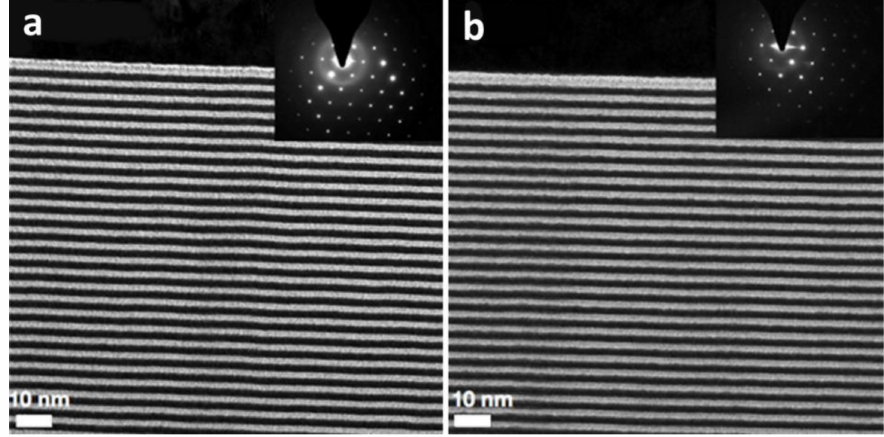
Figure 13. Cross section TEM images of the same WC/SiC multilayer as deposited ( a ) and after annealing to 700 ◦ C for 24 h ( b ); Annealing increased the multilayer period from 3.84 nm to 3.88 nm. The electron diffraction pattern in the upper right corner shows Bragg spots from the substrate (single crystal Si) and faint diffuse ring due to the multilayer. Difference in the intensity of this ring is due to different exposure